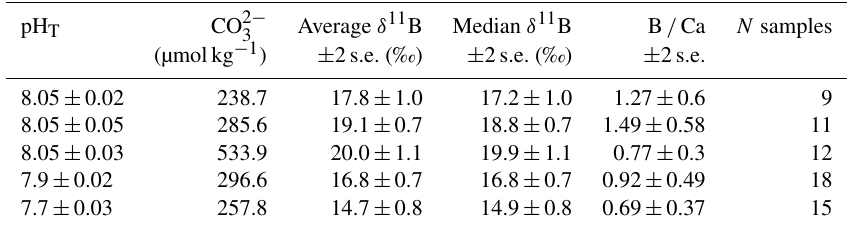
Table 3. Average (B / Ca) and average and median δ 11 B values for the different experimental